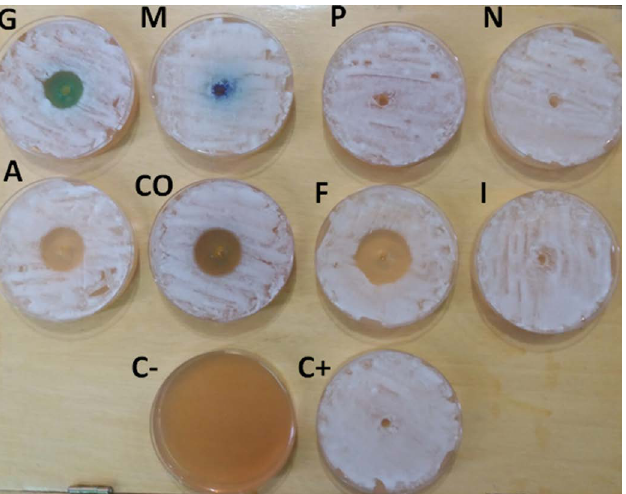
Fig. 2. Inhibition zone diameter, G= Malachite green 5mg/l , M= Methylene blue 10mg /l , P= Potassium permanganate 20 ppm, N= NaCl 5%, A= Quaternary ammonium 0.5ml/l, CO= Copper sulfate 0.5mg/l, F= Formalin 250 ppm and I= Povidone iodine 100mg/l, C+=Control positive, C- = Control